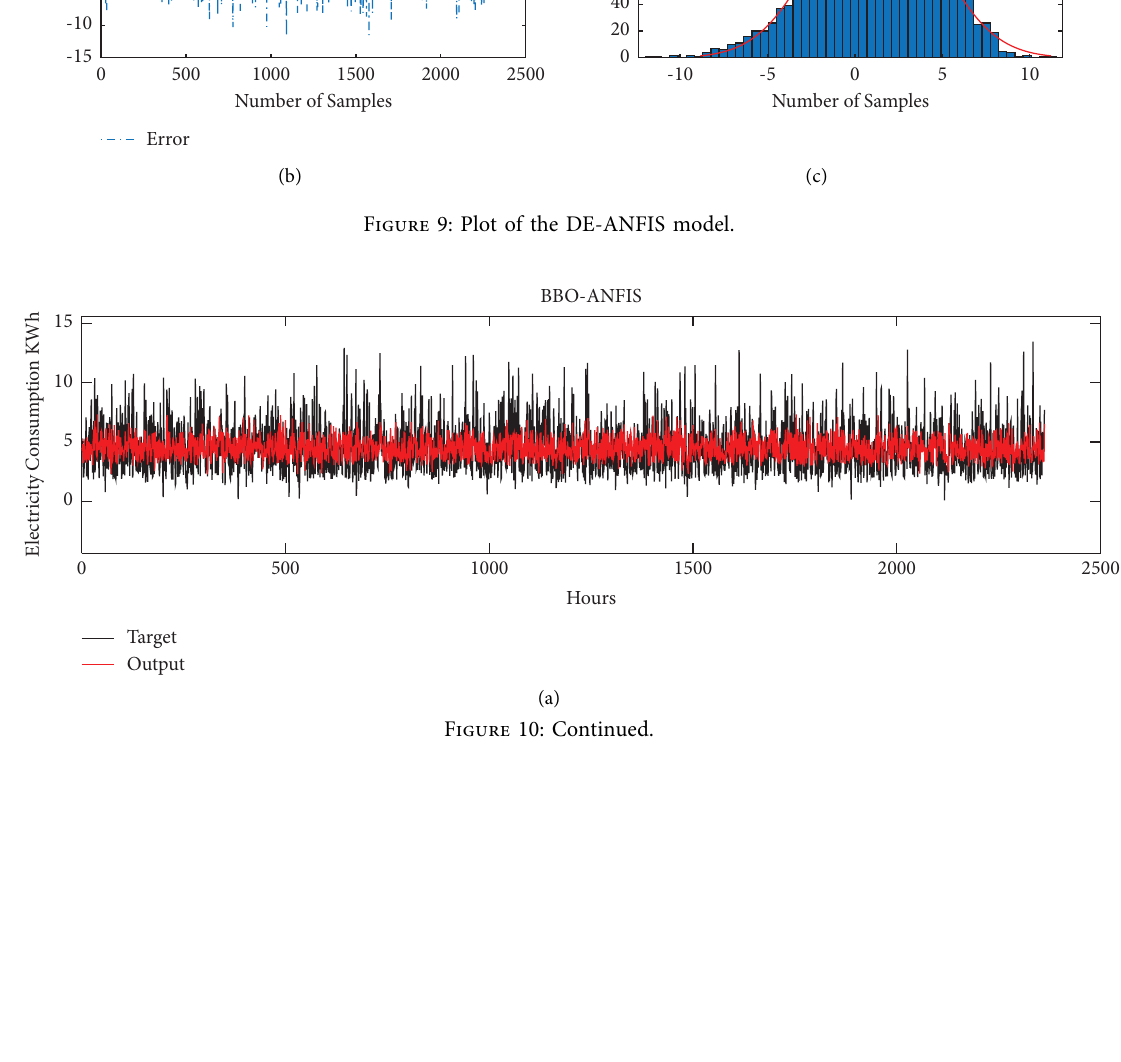
Error Mean = 1.1878, Error St.D. = 3.3446